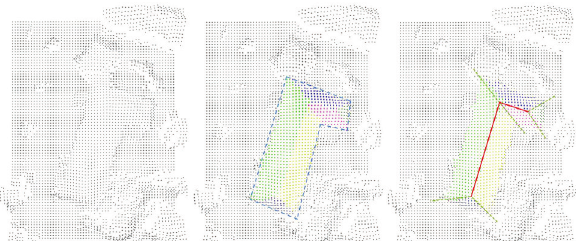
Figure 5. The output of the bottom-up process: the point cloud (left), the roof points (middle) labeled with colors indicating a rough building outline (blue dashed contour), and horizontal (red lines) as well as diagonal (green lines) ridges